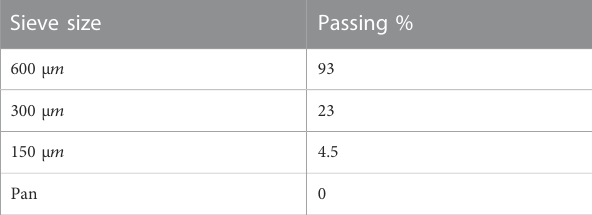
TABLE 3 Sieve analysis of silica sand. Sieve